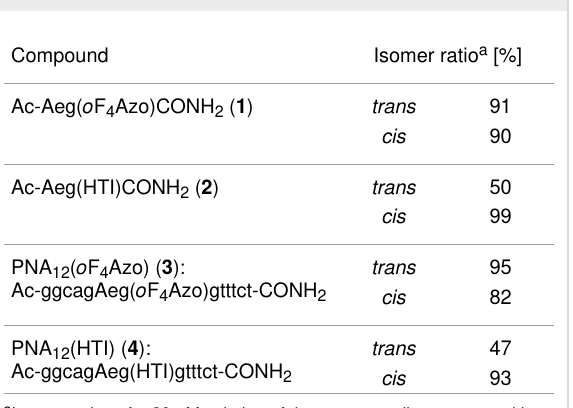
Table 1: Isomerization conversions at the photostationary state (PSS).